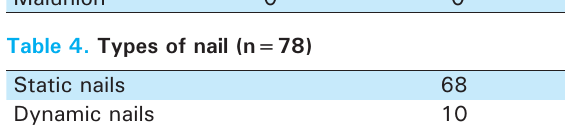
Table 4. Types of nail (n=78)